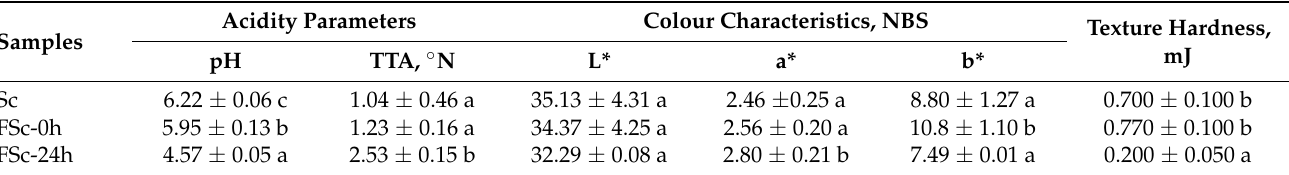
Table 2. Acidity characteristics (pH and total titratable acidity), colour coordinates and hardness of scalded (Sc) and scalded-fermented (FSc) (after 0 and 24 h of fermentation) rye wholemeal